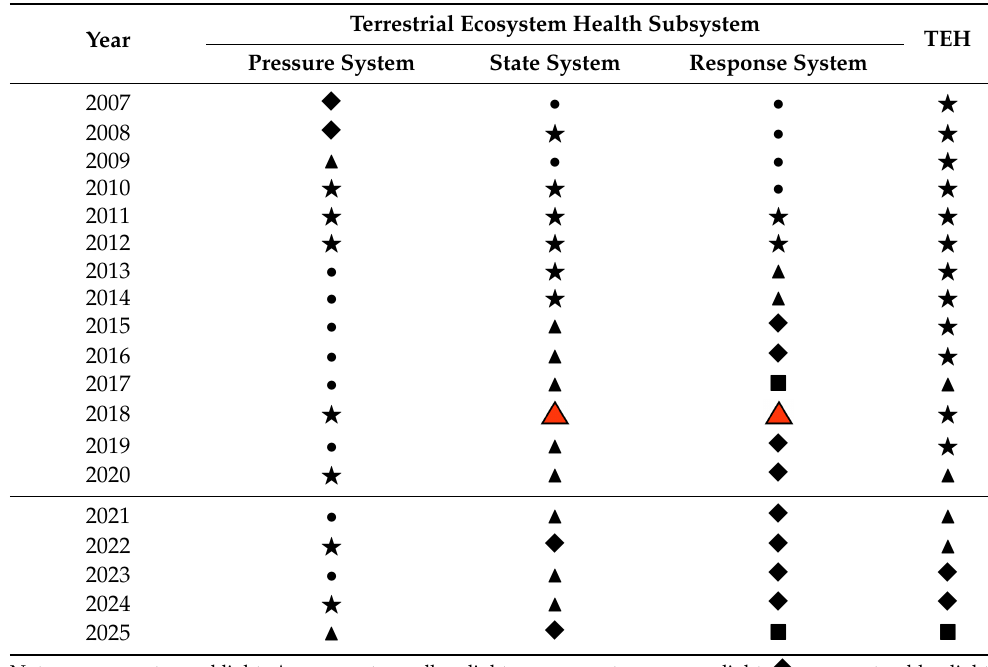
Note: ● represents a red light, ★ represents a yellow light, ▲ represents an orange light, ◆ repre- sents a blue light, and ■ represents a green light.